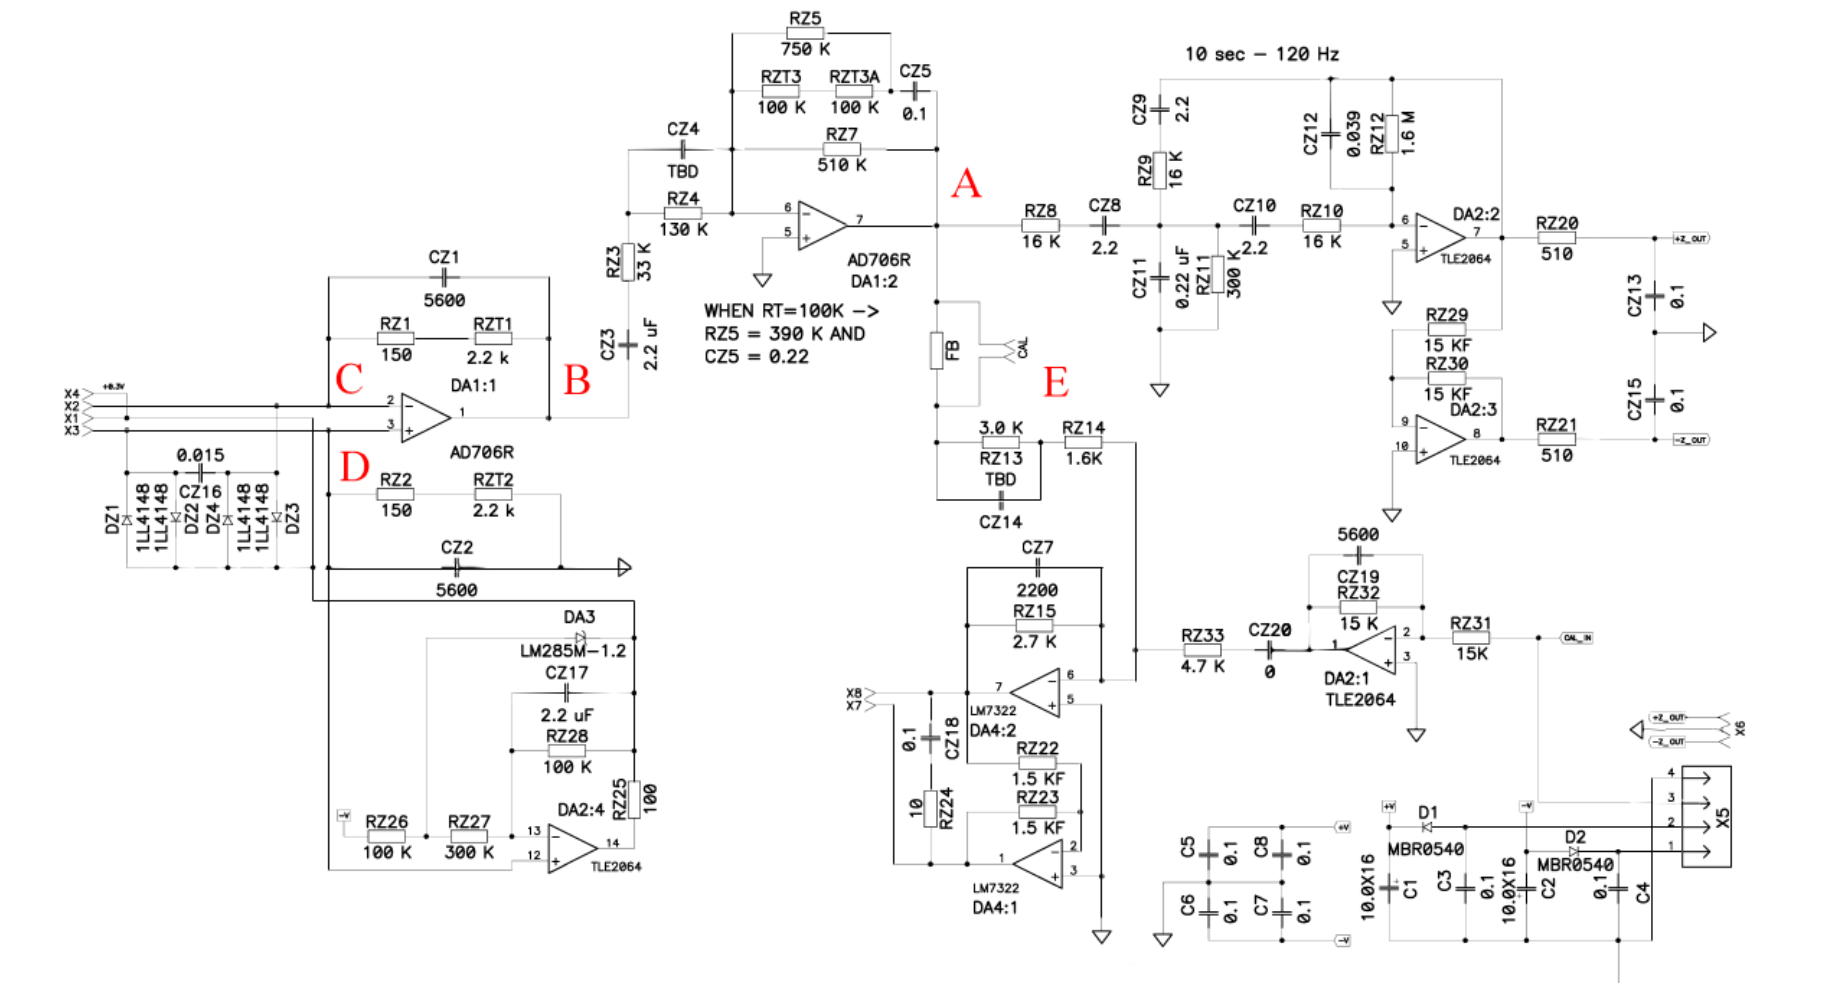
Figure 2. Schematic of the electronic board for each of the test